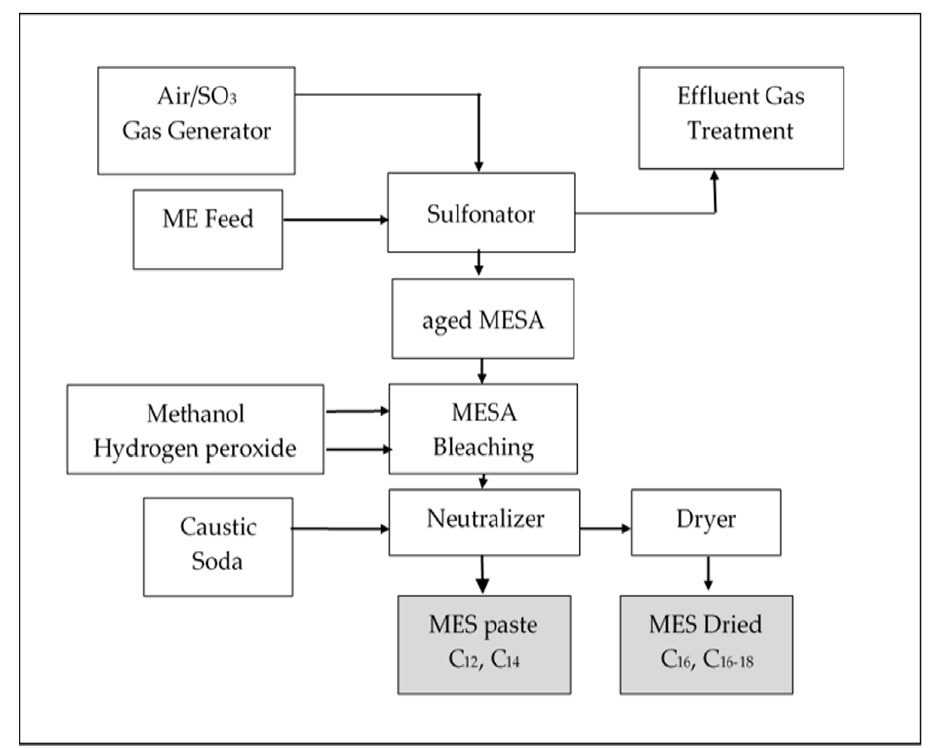
Figure 1. Block diagram for the methyl ester sulphonates (MES) process pilot plant at the Malaysian Palm Oil Board (MPOB).